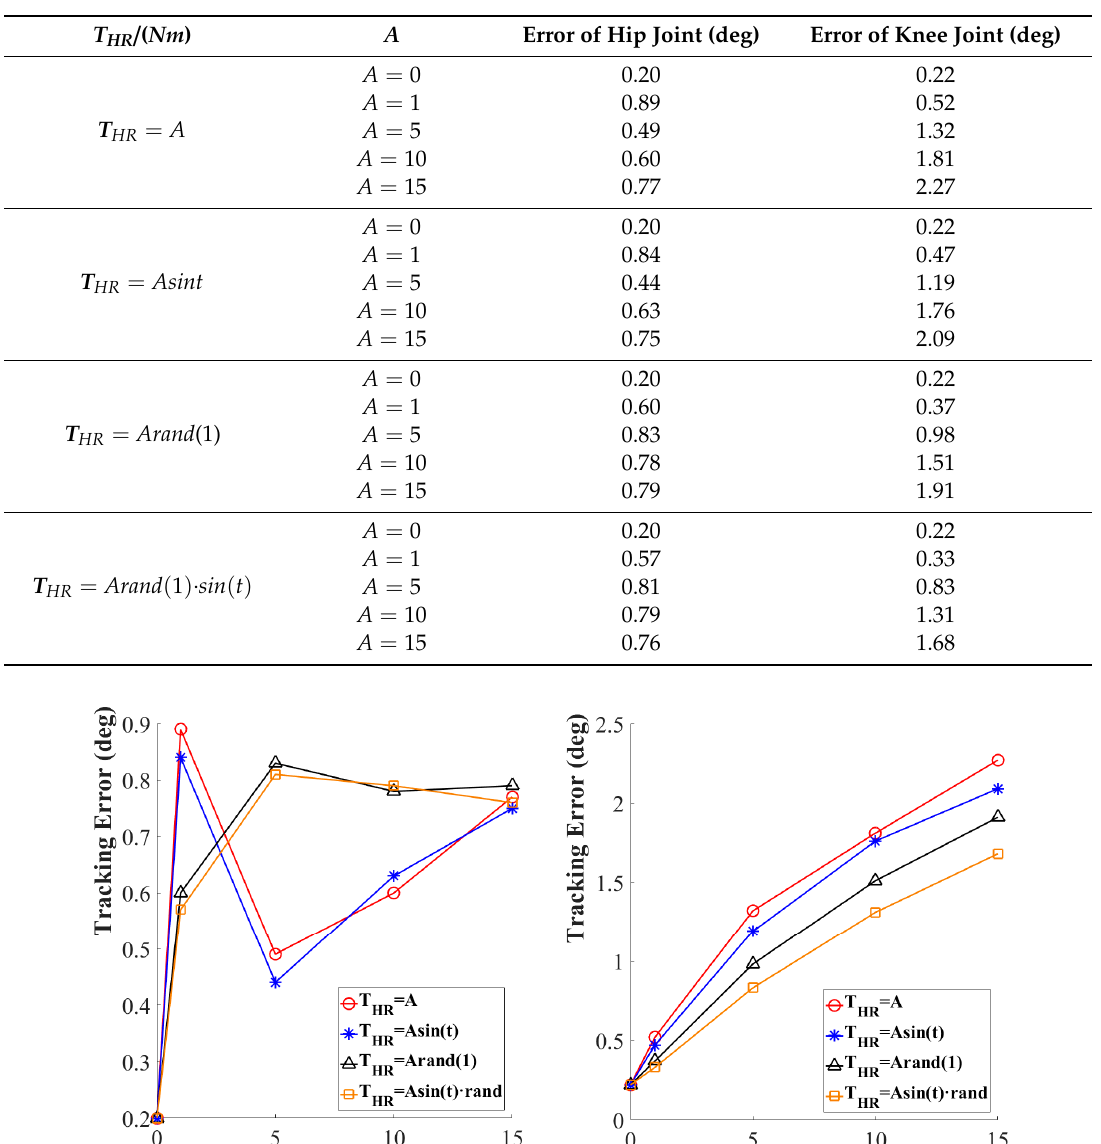
Table 1. The tracking errors with di ff erent forms and amplitudes of T HR .